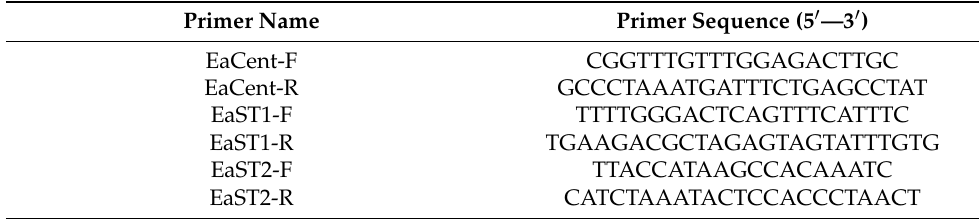
Table 2. The designed primer sequence by